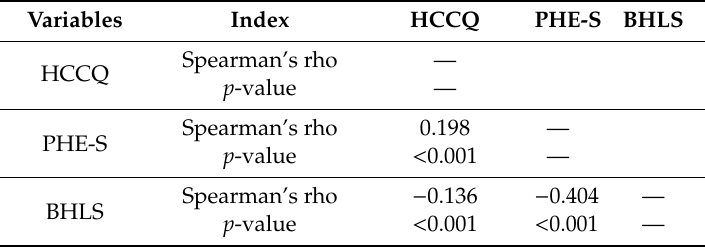
Table 3. Correlation between study’s measures.